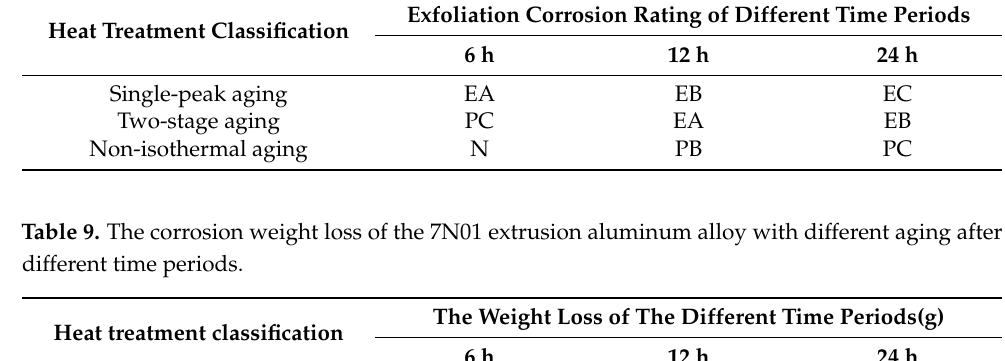
Table 8. The corrosion rating of the 7N01 extrusion aluminum alloy with different aging after different time period.